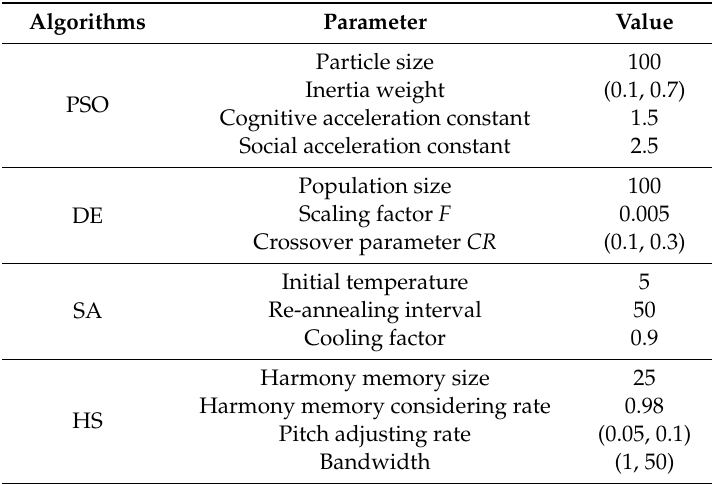
Table 1. Parameter settings of heuristic algorithms.